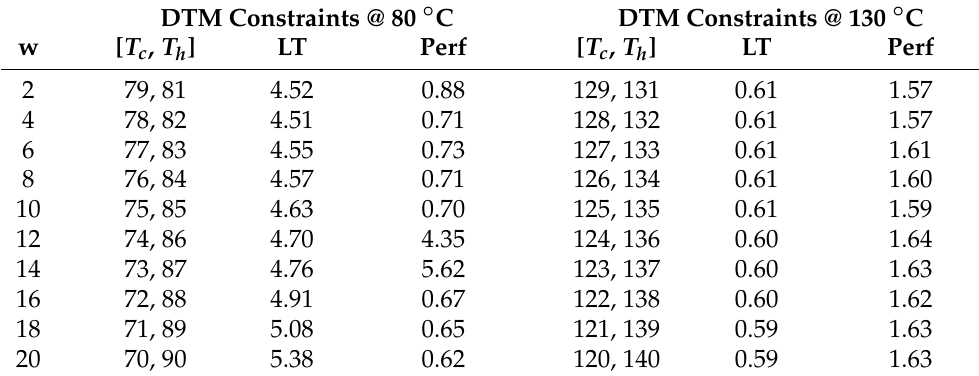
Table 6. Lifetime and performance trade-off of the constraints ( w < 20 ◦ C).